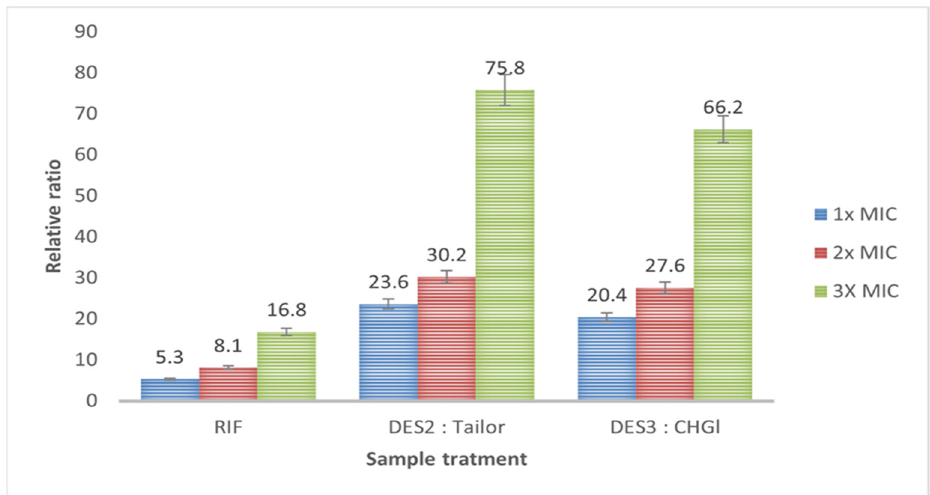
Figure 3. The effect of DES2: Tailor and DES3: CHGl extracts of R. officinalis and RIF on the release of cell constituents at 280 nm from MDR– Mycobacterium tuberculosis .